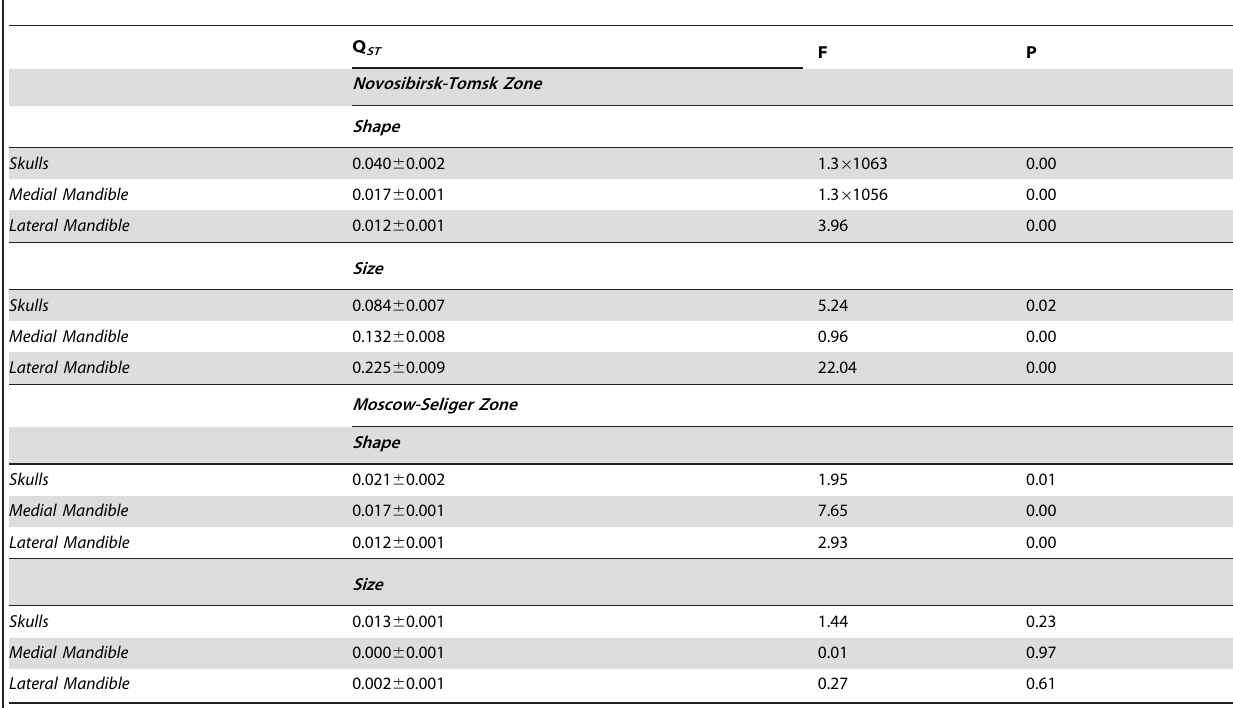
Table 1. Phenotypic differentiation at hybrid